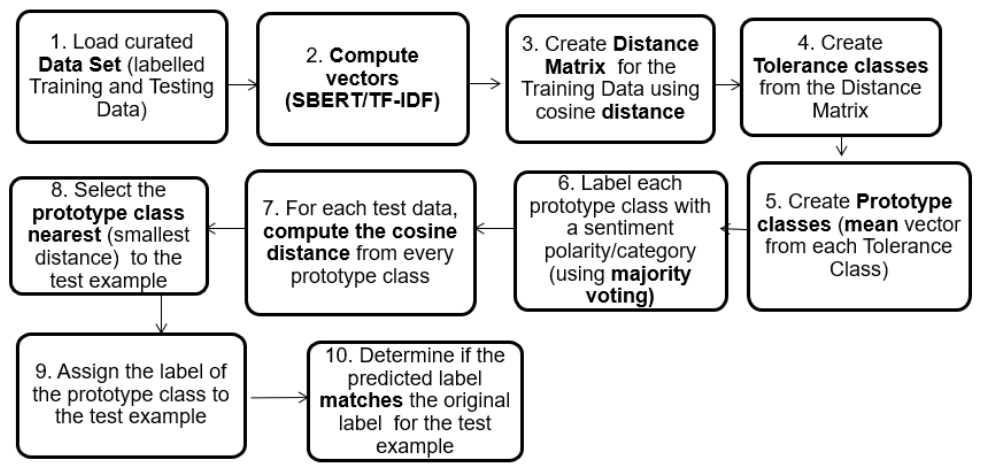
Figure 1. High-level process flow of the proposed TSC